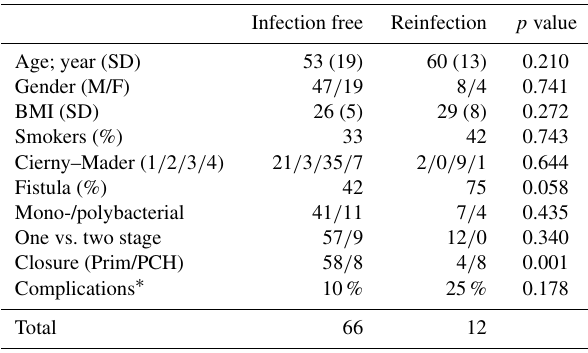
Table 5. Analysis on possible risk factors for recurrence of infec- tion.